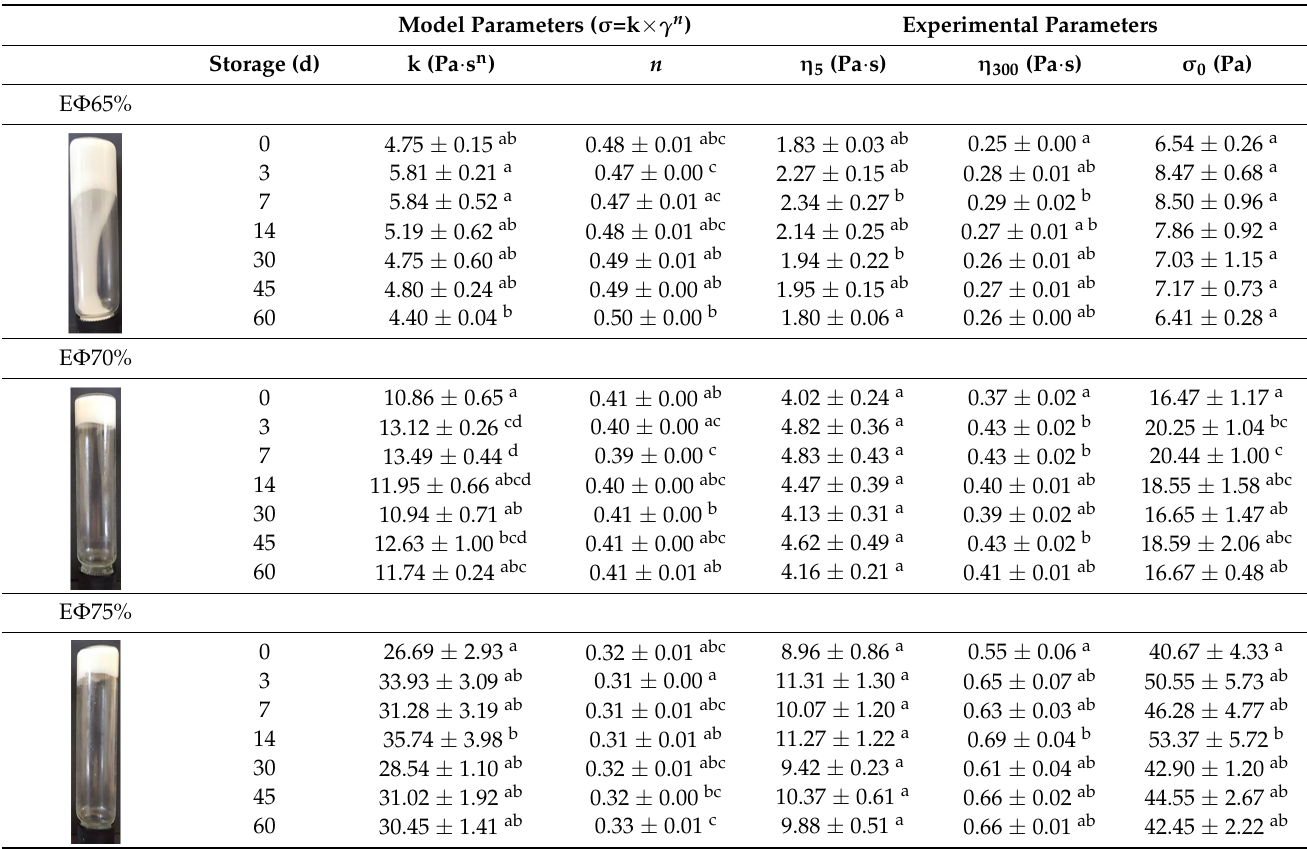
Table 2. Flow consistency index (k) and flow behavior index ( n ) of the power law model (R 2 > 0.99), and apparent viscosity ( η ) at a shear rate of 5 ( η 5 ) and 300 s − 1 ( η 300 ) and the initial shear stress ( σ 0 ) throughout the 60 days of storage at 25 ◦ C. Model Parameters ( σ =k × γ n ) Experimental Parameters